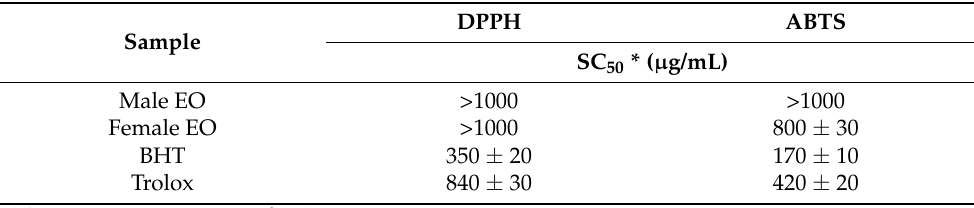
Table 5. Antioxidant activity of essential oils of H. racemosum